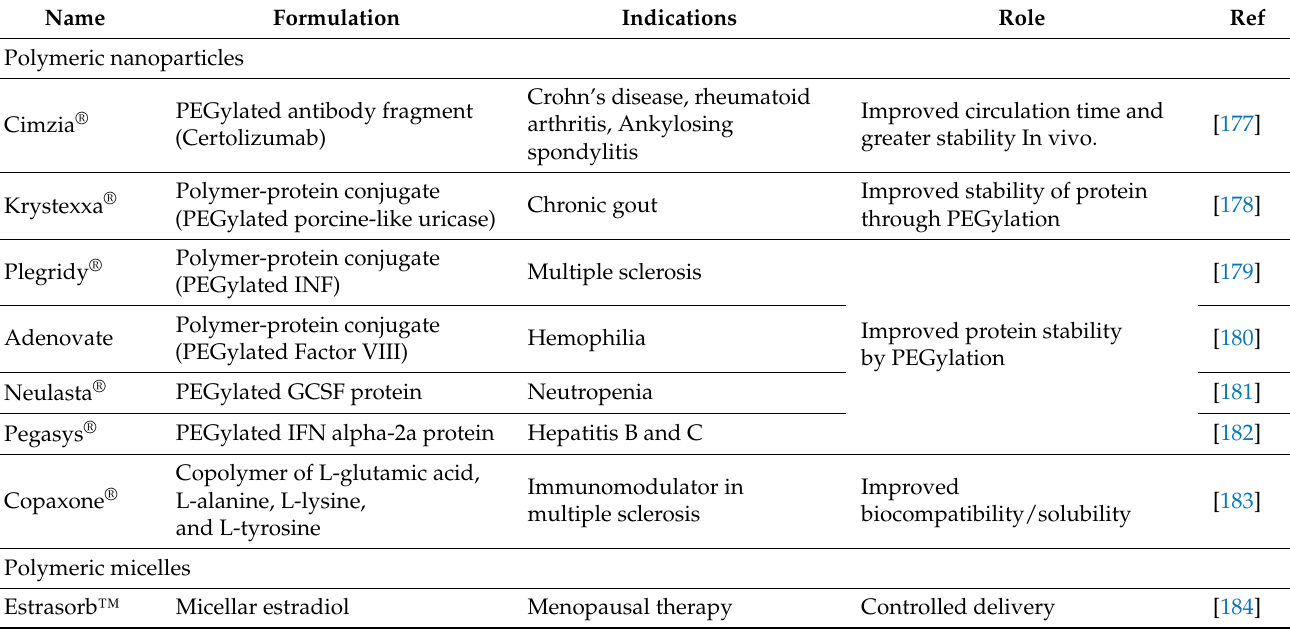
Table 6. USFDA-approved polymeric products.